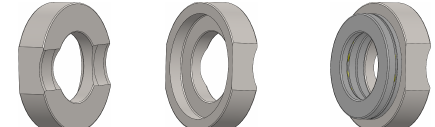
Figure 4: The sensor layout on the test bearing hous- ing: (a) Front of the housing with the bearing in the middle and sensors around it. (b) Side of the test bearing housing with the proxim- ity sensor location.